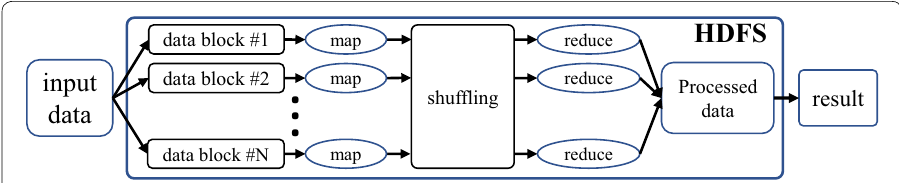
Fig. 3 MapReduce process on Hadoop